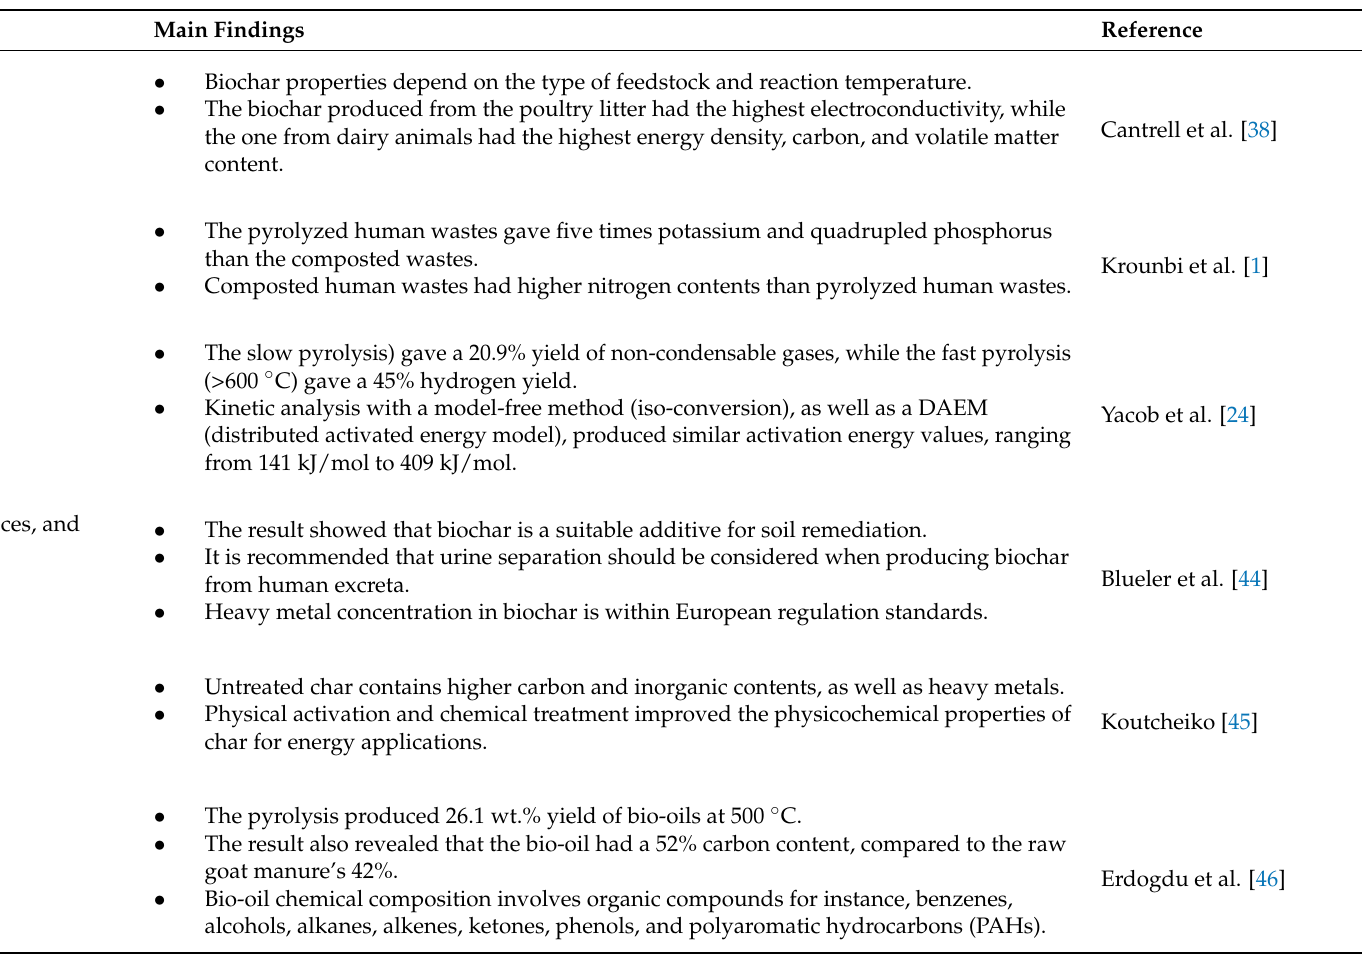
Table 4. Summary of past studies on the pyrolysis of human and livestock